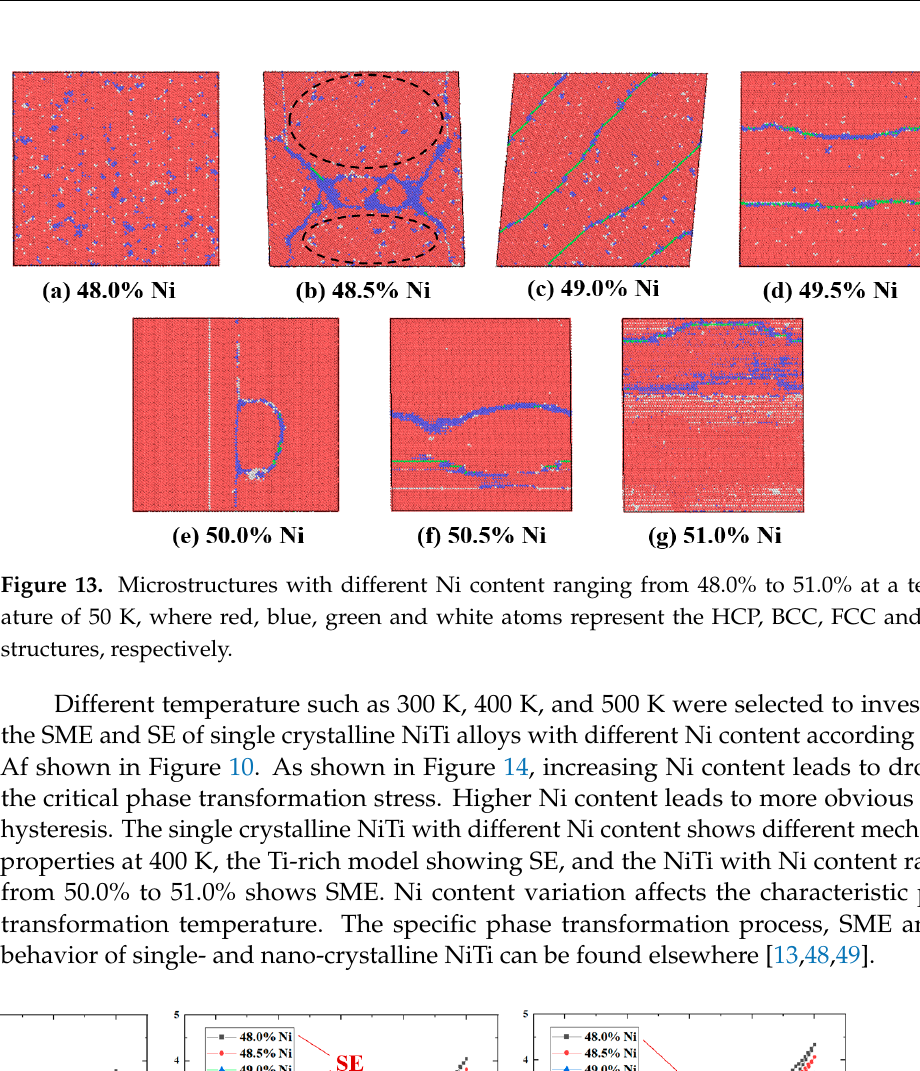
Figure 12. Variation of the BCC-FCC boundary volume fraction and Ni content in the boundary with global Ni content ranges from 48.0% to 51.0% at a temperature of 50 K.